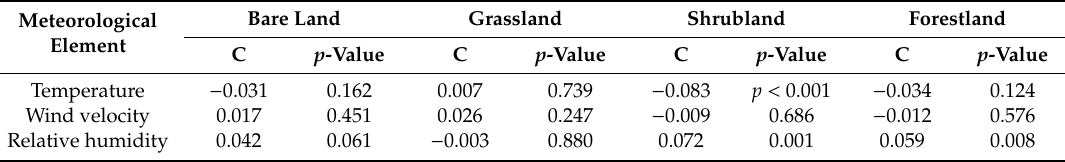
Table 12. Results of the Spearman correlation coe ffi cient and significance level between volumetric soil moisture content variations, per hour, and variation of temperature, wind velocity, and relative humidity per hour in a period without